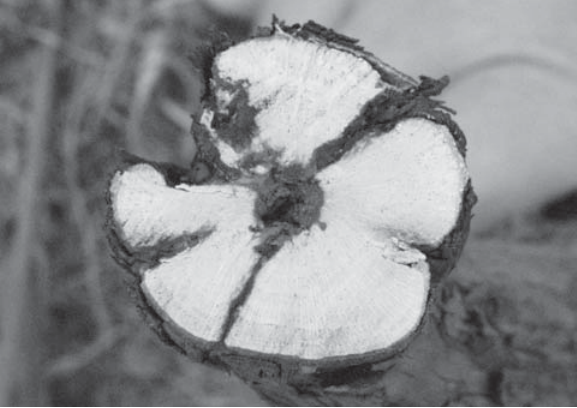
Fig. 1. Black goo symptoms in infected ‘Ramsey’ rootstock, with P. chlamydospora sporulation detected in